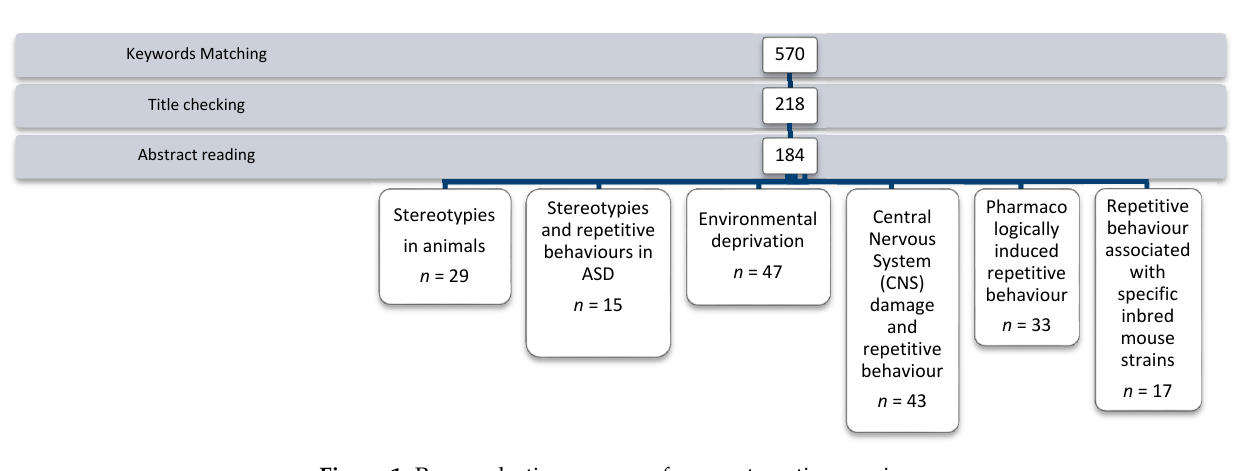
Figure 1. Paper selection process of our systematic mapping.